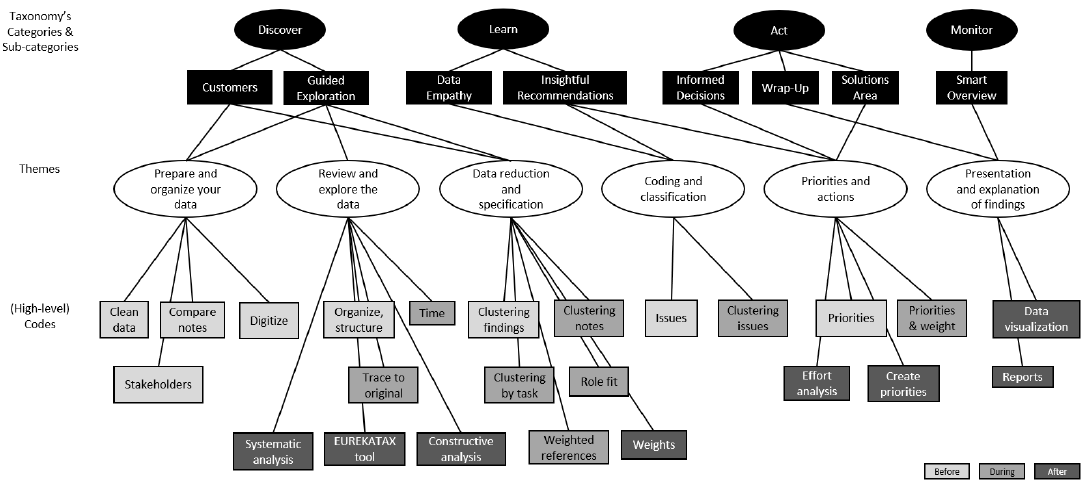
Figure 11. Thematic map—illustrating the relationship between themes, codes and taxonomy